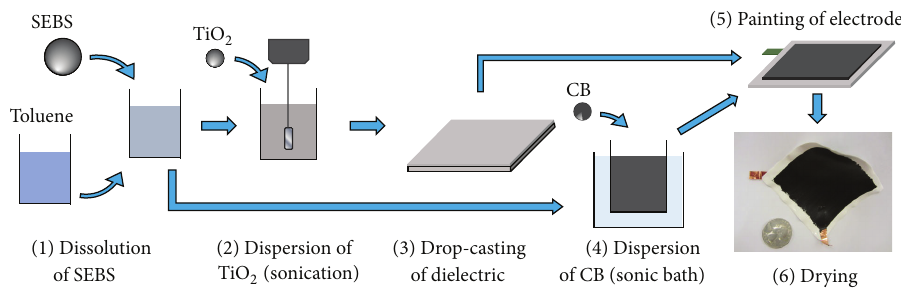
Figure 1: Fabrication process of the